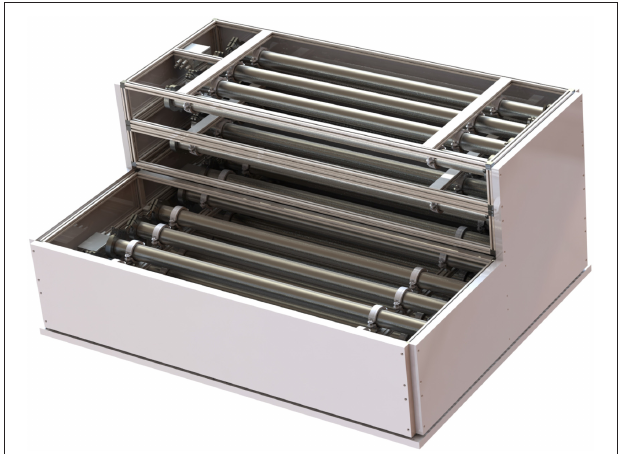
FIGURE 6 | Setup of the large-area boron-lined detector for mobile measurements. Six base units are shown, assembled in two rows with two units each and two units on top of the back row. Each base unit is equipped with moderator sheets on three sides.